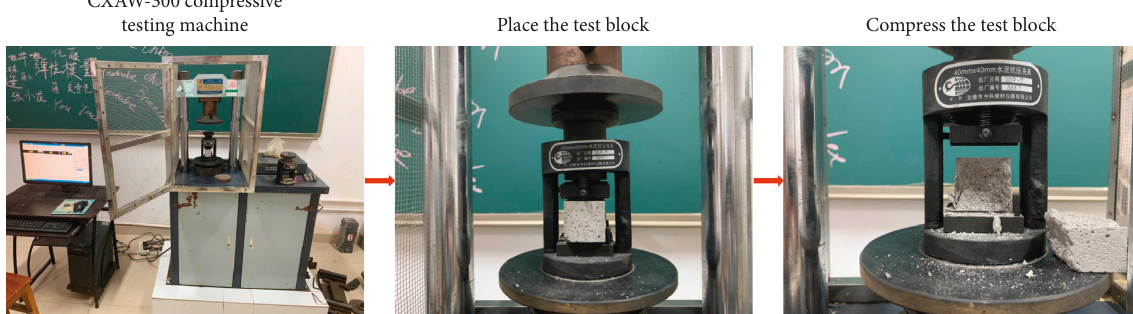
Figure 9: Compressive strength test of solidified cement